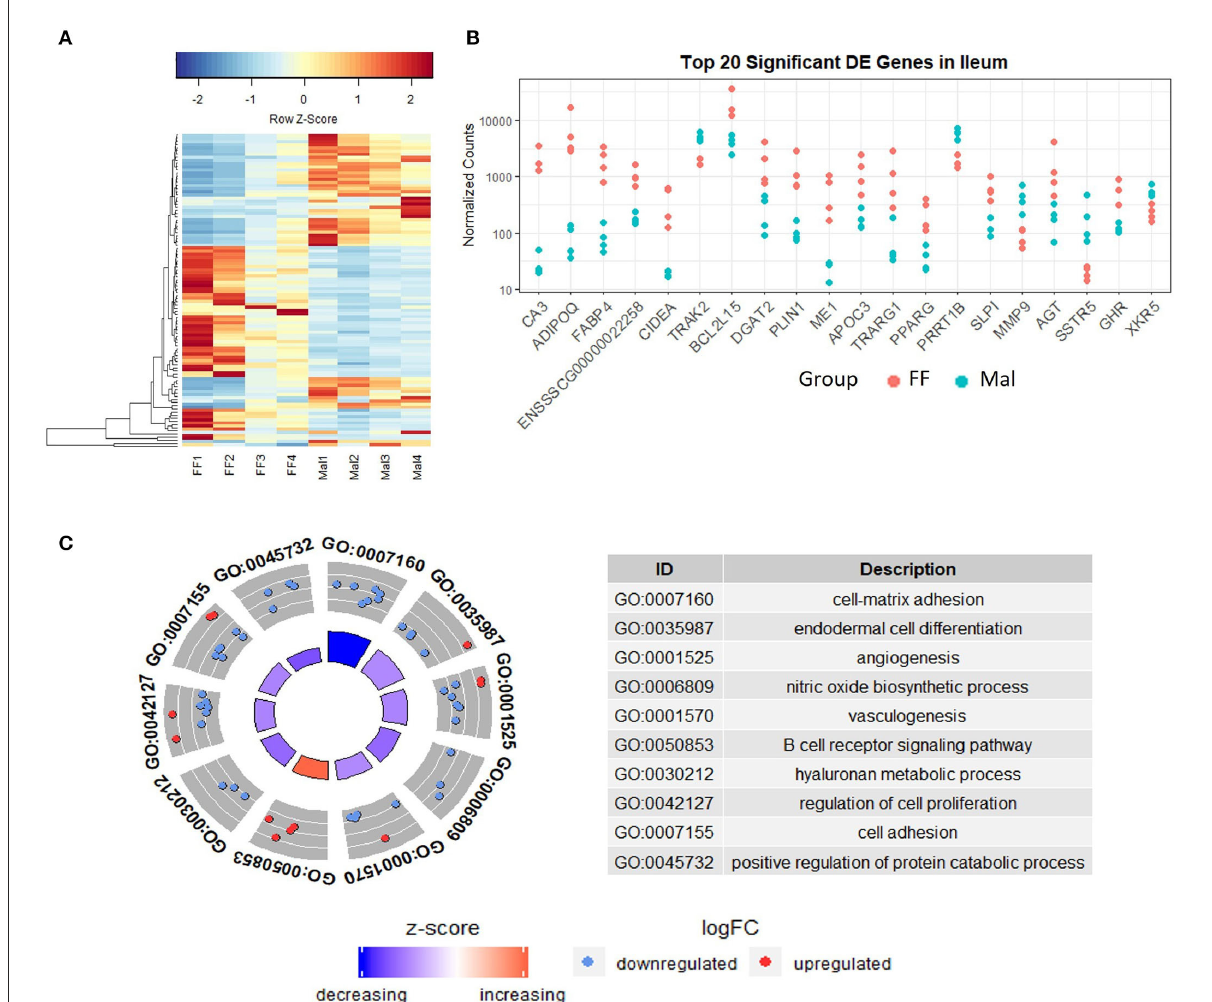
FIGURE4 Gene expression and pathway analysis in the ileum of full-fed and malnourished pigs. (A) Heatmap with hierarchical supervised clustering of the normalized counts using Euclidean distance for the 100 DE genes with the greatest variance between the full-fed (FF, n = 4) and malnourished (Mal, n = 4) groups in the ileum. Z-score represents upregulated (red) and downregulated (blue) genes, with a color gradient indicating expression level. (B) Plot of the normalized counts of the 20 genes with the lowest padj values in the jejunum of FF [ n = 4 (pink)] and Mal [ n = 4 (blue)] animals. The genes are ordered left to right from lowest to greatest padj values. (C) Gene ontology analysis comparing the DE genes in the ileum of FF and Mal animals. The pathways displayed had p -values < 0.005, with the height of the inner circle of the graph representing significance and the color representing the pathway status (increased or decreased expression compared to FF samples). The outer circle represents the genes in the pathway that are up or downregulated in the malnourished group.